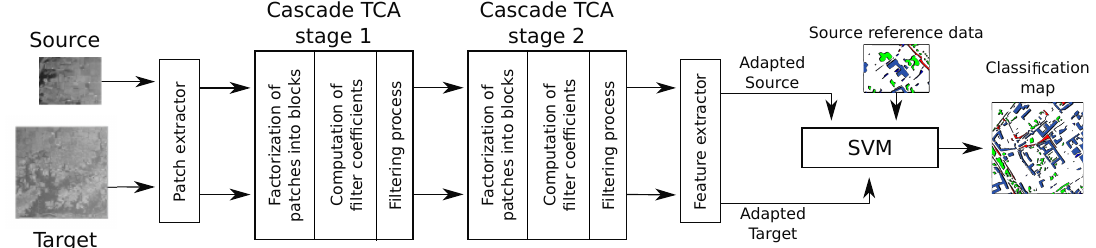
Figure 3. Block diagram of the classification scheme based on TCANet.